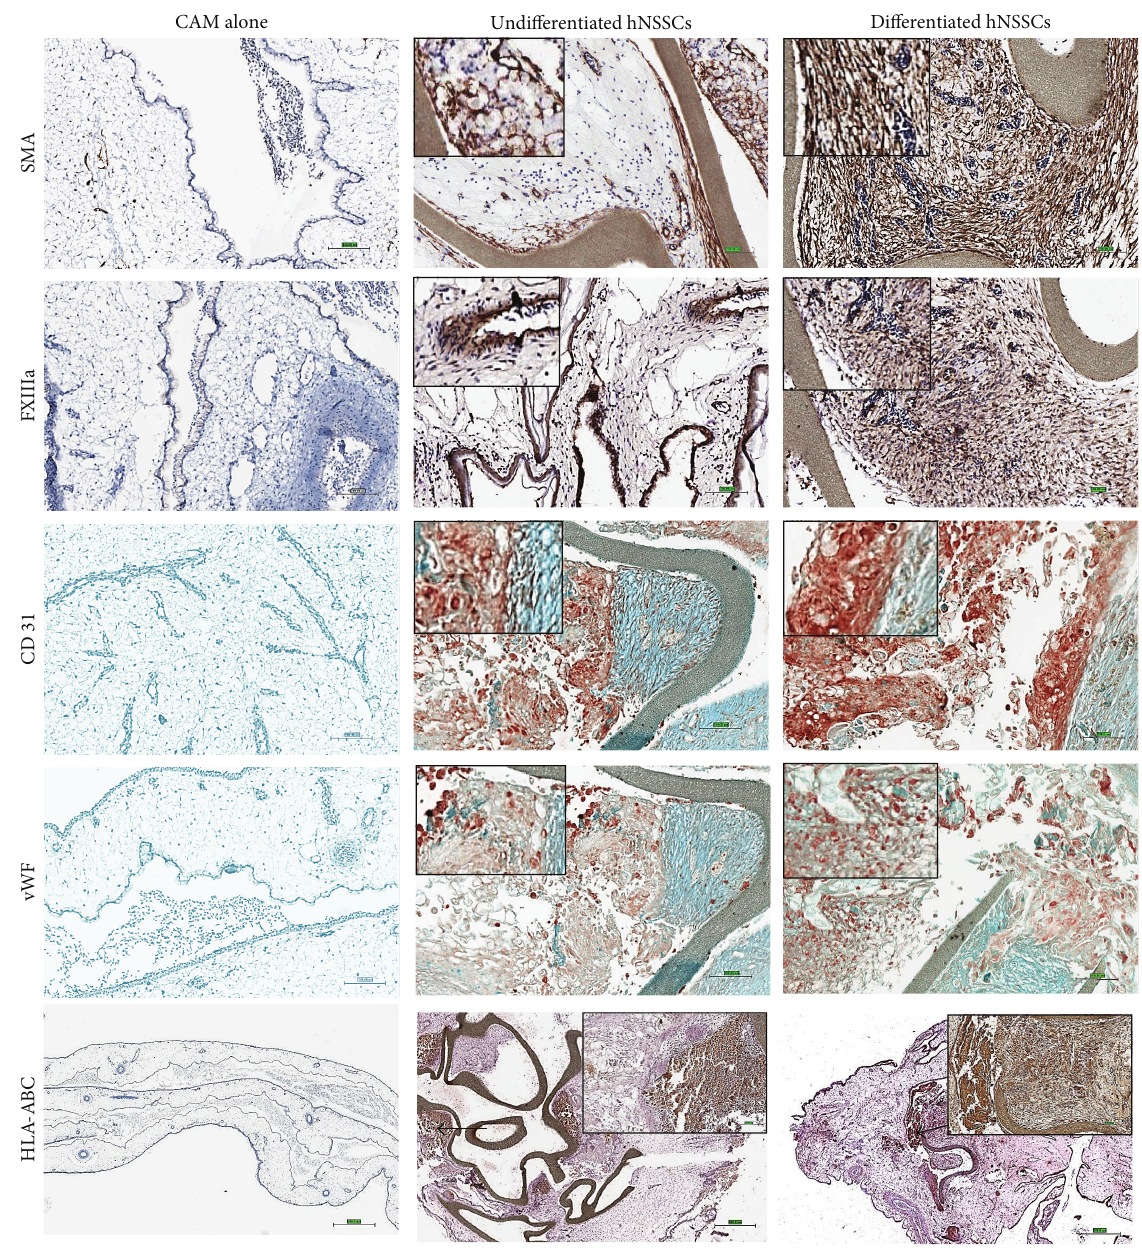
Figure 4: Immunohistochemical staining of CAM alone and CAM grafted with hNSSCs for endothelial-related markers. CAMs transplanted with undifferentiated and differentiated hNSSCs (10 days) were processed and stained using the indicated antibody. Brown colour indicates areas with positive staining for the respective cell marker (smooth muscle actin (SMA), factor XIIIa, CD31, and von Willebrand factor (vWF)). The human leukocyte antigen (HLA-ABC) was used to differentiate the engraftment of human cells from chick cells (Bar = 100 𝜇